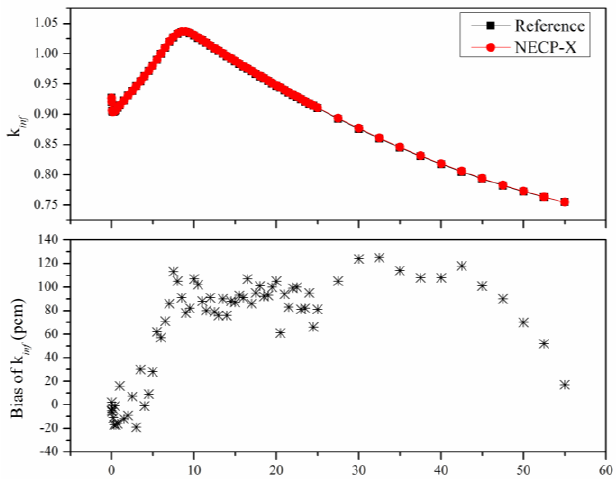
Figure 9. Comparison of k inf for VERA 2P